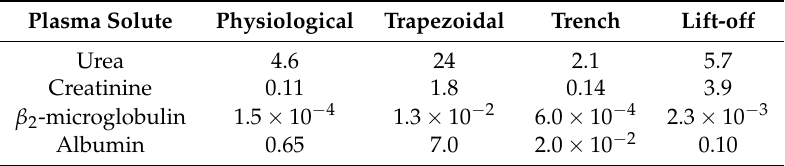
Table 2. Comparison between target physiological concentrations of various toxins and steady-state concentration results from three-dimensional finite element models of practical geometries depicted in Figure 6. Values are steady state concentrations in mM. While the trapezoidal and lift-off designs have too much clearance of albumin and not enough of smaller solutes, the trench design achieves a more desirable distribution of steady state